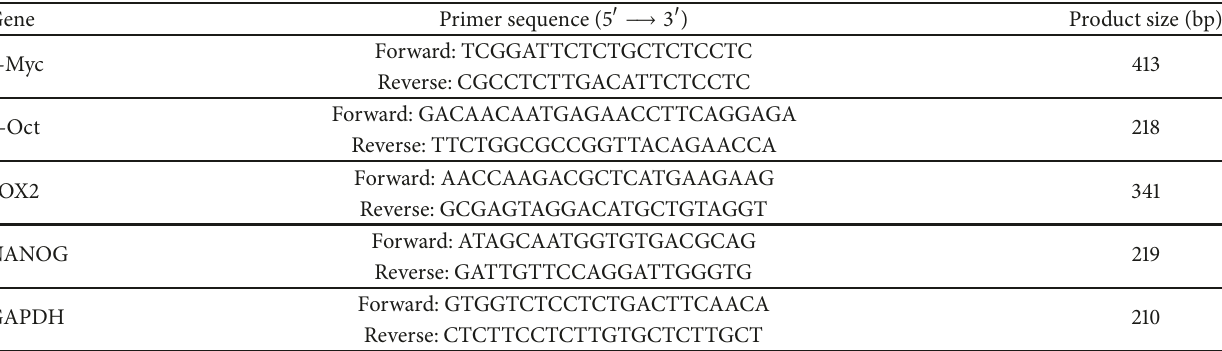
Figure 3: Transfection of HEK-293T for recombinantviral particles production. (a)The nontransfected cultureof HEK-293T. (b) Transfected HEK- 293T at 24 hours after transfection by pCDH- EF1 𝛼 - RIL- 23R- PGK-copGFP. (c) Flow cytometry analysis shows High expression of GFP in HEK- 293T and the high rate of transfection. Table 1: Primer sets used for